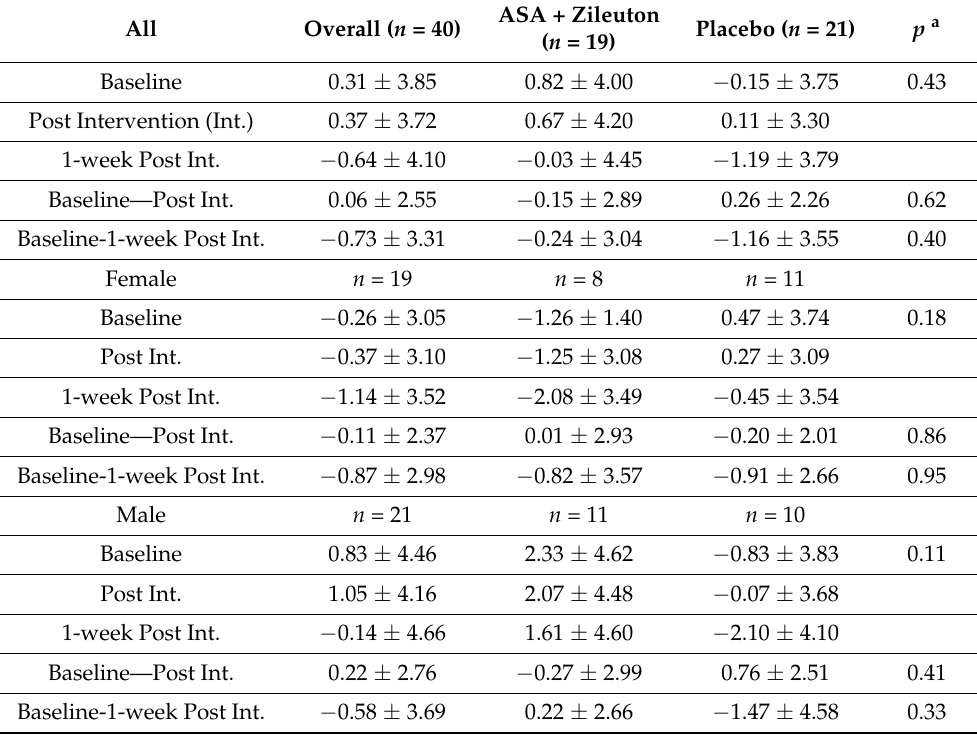
Table 4. Baseline and changes in a smoking-associated gene-expression signature derived from nasal and bronchial brushings by Zhang [29]; data is presented as mean ± standard deviation. ASA + Zileuton Placebo ( n = 21) p a All Overall ( n = 40) ( n = 19) Baseline 0.31 ± 3.85 0.82 ± 4.00 − 0.15 ± 3.75 0.43 Post Intervention (Int.) 0.37 ± 3.72 0.67 ± 4.20 0.11 ± 3.30 − 0.64 ± 4.10 − 0.03 ± 4.45 − 1.19 ± 3.79 0.06 ± 2.55 − 0.15 ± 2.89 0.26 ± 2.26 0.62 − 0.73 ± 3.31